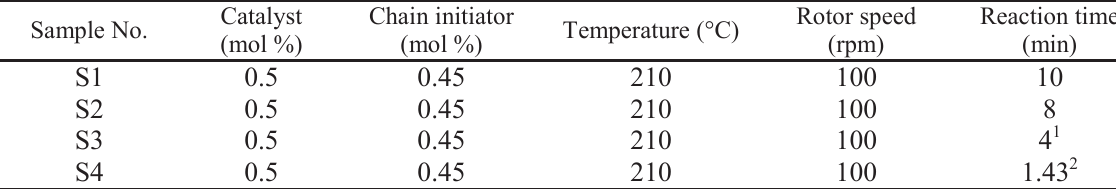
Table 1. Samples recipes and polymerization reaction